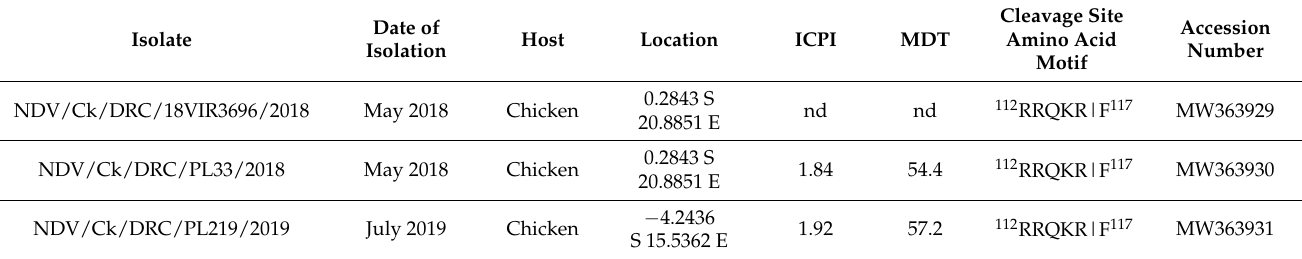
Table 1. Characteristics of the Newcastle disease viruses isolated in the Democratic Republic of the Congo in 2018 and 2019. Date of Isolate Host Isolation